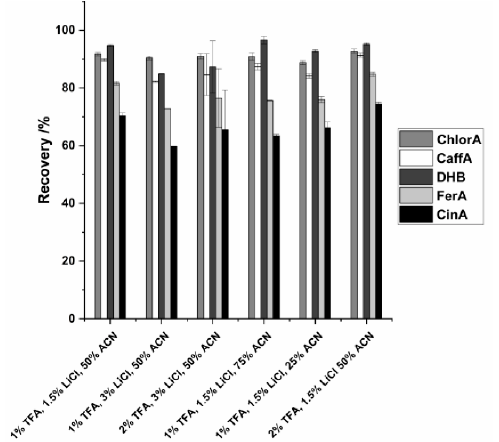
Figure 2. Analyte recovery results obtained from DSPE experiments with the poly(n-VIM/C 6 -bis- VIM) polymer with a monomer to crosslinker ratio of 11.50 to 1, by applying different eluting solutions. Standard deviations are given as error bars.